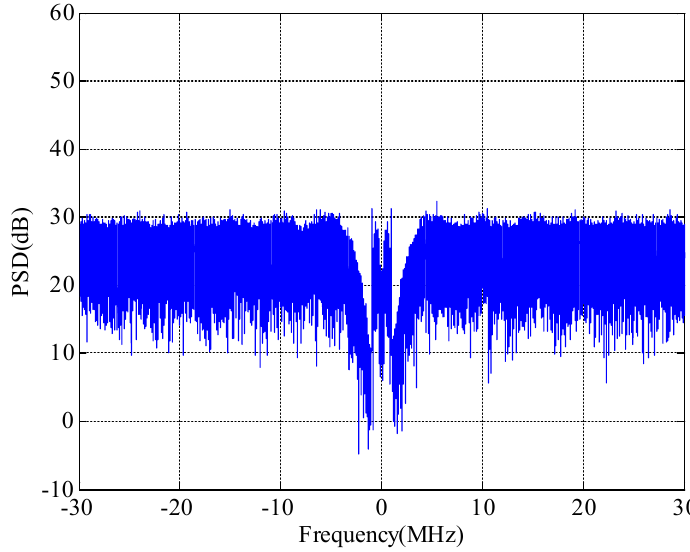
Figure 5. Spectrum after anti-jamming in the frequency domain.